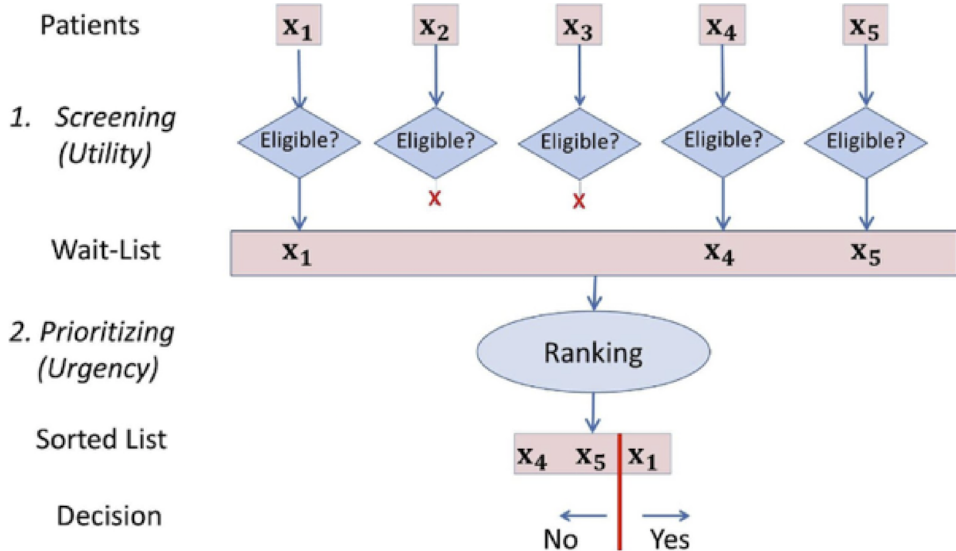
Fig 1. Two-step process. Two-step process for determining which patients should receive a Liver Transplant: Screening, then Prioritizing. This paper focuses on the initial “Screening” step.